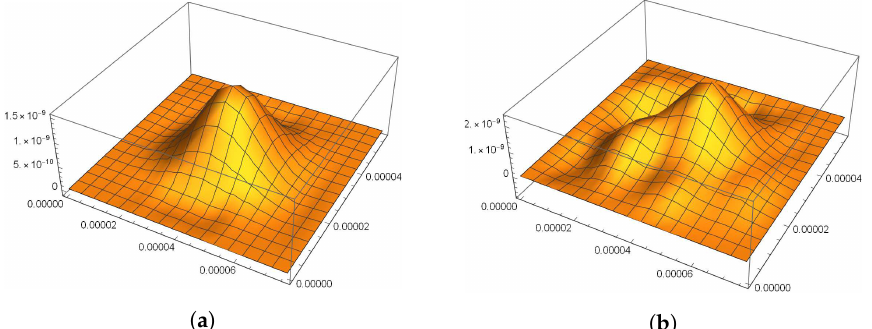
Figure 11. Application of the SVD-based regularization strategy. ( a ) Recovery of the load correspond- ing to Figure 7a when the regularization strategy is applied with N Trunc = 20. ( b ) Recovery of the load corresponding to Figure 7b when the regularization strategy is applied with N Trunc = 20. The absolute and relative errors in the recovery process are shown in Table 5. Table 5. Absolute and relative errors for the recovery of a discontinuous